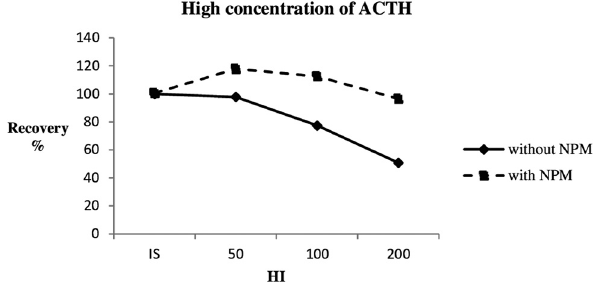
Figure 4: High concentration of insulin recovery graphic between without NPM and with NPM groups. In 100 and 200 HI, where hemolysis was significant, insulin concentrations decreased to respectively 83 and 70% in the group without NPM. By adding NPM at the samedegreeof hemolysis (100 and200 HI), the insulin values increased to 93 and 93%,